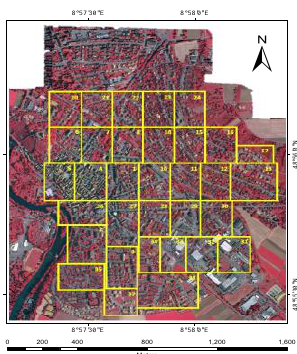
Figure 2. The true orthophoto of the test area, which is divided into 33 tiles with different sizes.